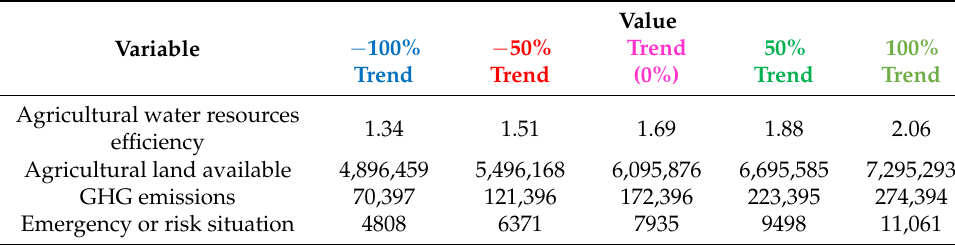
Table 5. Values of interest variables for each simulated